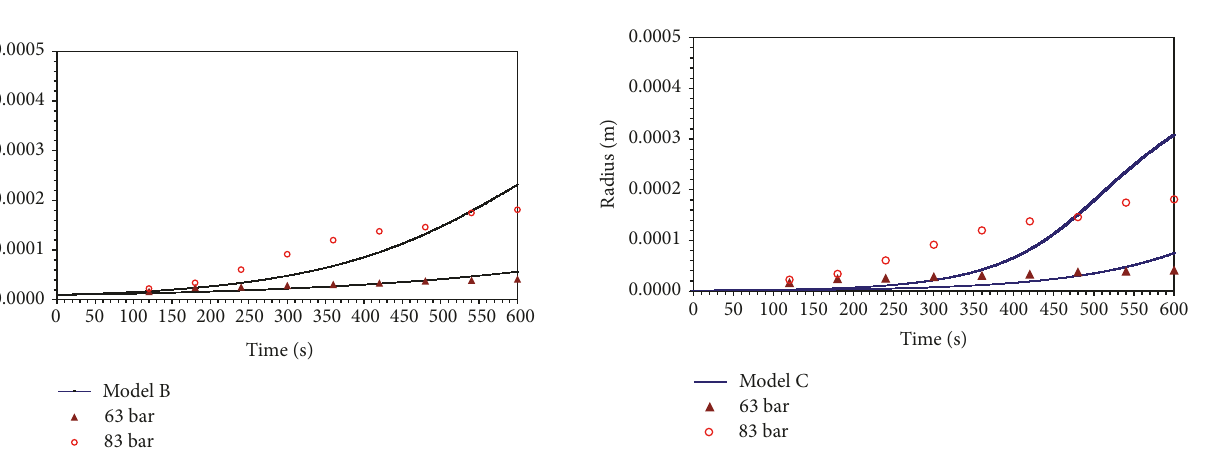
Figure 16: Model A versus experimental data for bubble growth at 100 ∘ C.